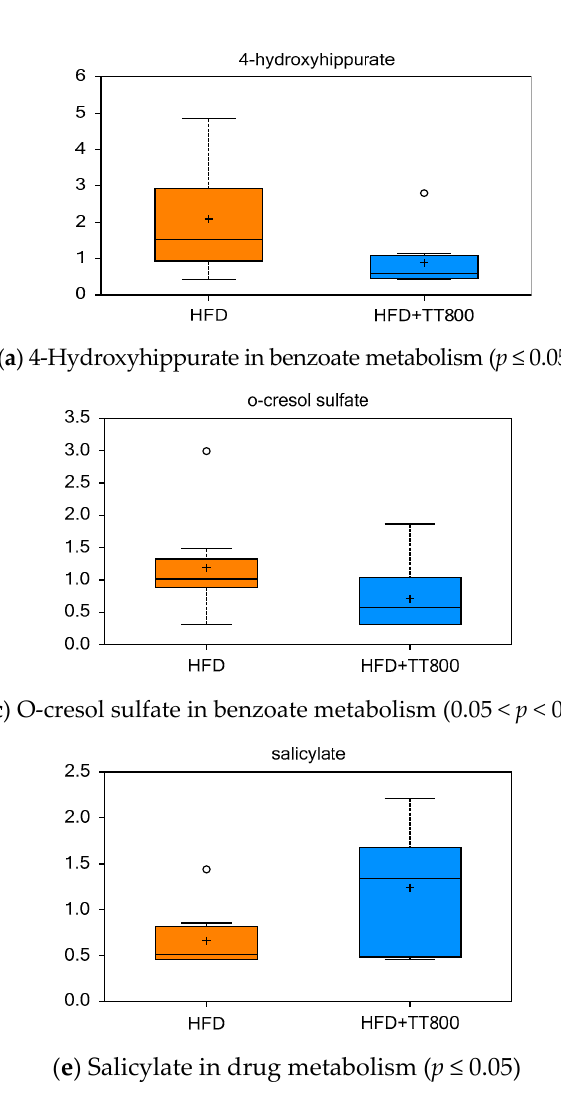
Figure 4. Effect of TT supplementation on serum xenobiotic metabolites. Supplementation with TT800 in mice fed a HFD may help reduce bacterial products of phenylalanine metabolism, and 4 hyrdoxyhippurate, as well as lower glucuranate. These compounds may be reduced with TT supplementation by changing gut microflora in mice. Each dietary group was comprised of n = 10 mice.